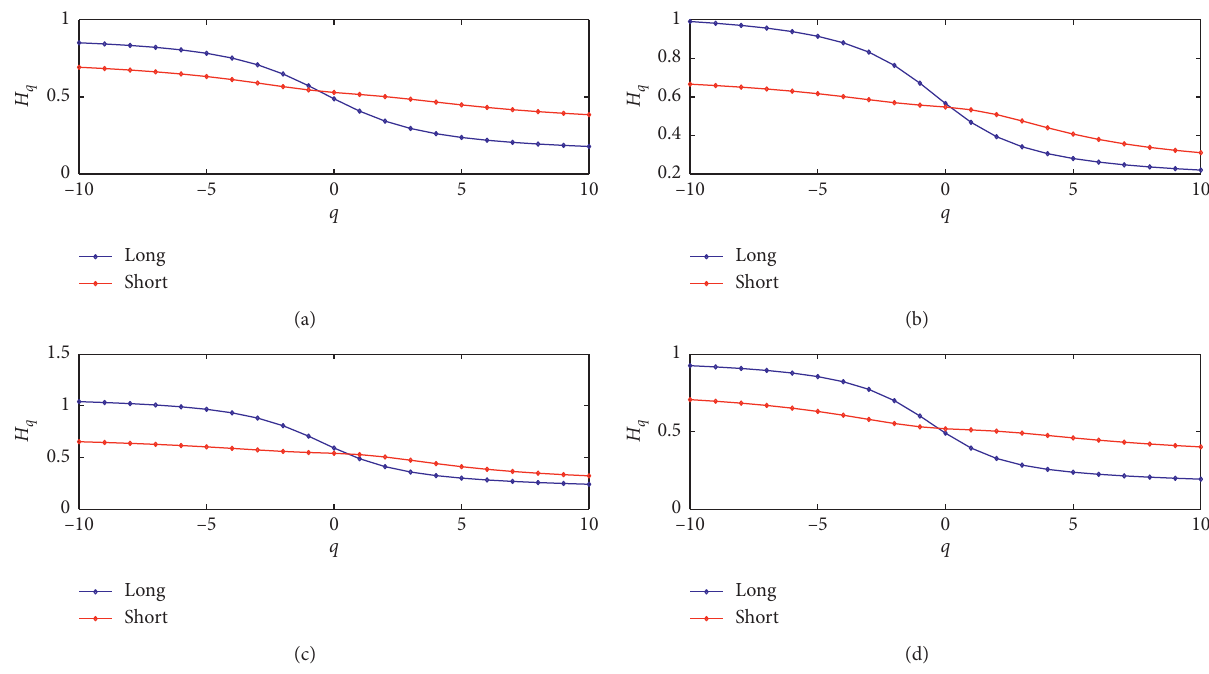
Figure 11: Short and long scaling exponents for Chinese stock market returns and market participation willingness. (a) SME-YSI. (b) SSE50-YSI. (c) CSI300-YSI. (d)